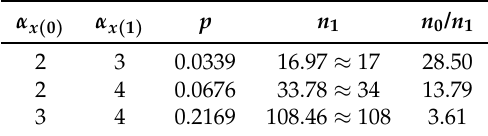
Figure 3. The objective function vs. p at n = 500, α y ( 0 ) = 2, α y ( 1 ) = 3, r f = 100 m , and r c = 500 m . Table 1. The optimum value of p , n 1 , and n 0 / n 1 at n = 500, α y ( 0 ) = 2, α y ( 1 ) = 3, r f = 100 m , and r c = 500 m